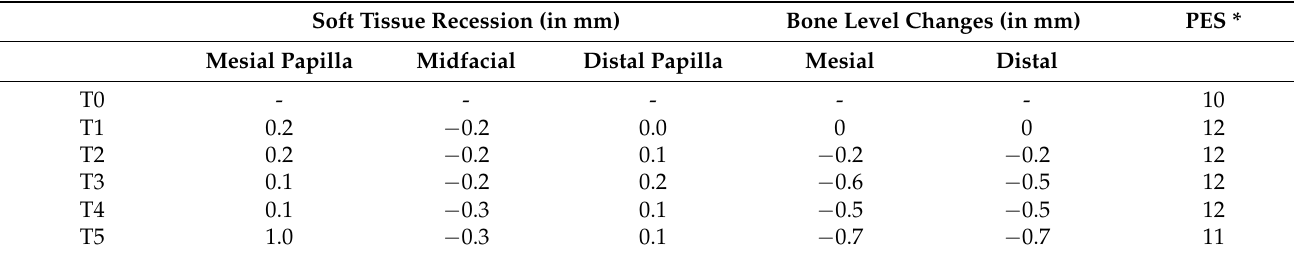
Table 1. Tissue changes and aesthetic outcomes over the various follow-up time points. Soft Tissue Recession (in mm) Bone Level Changes (in mm) PES * Mesial Papilla Midfacial Distal Papilla Mesial Distal